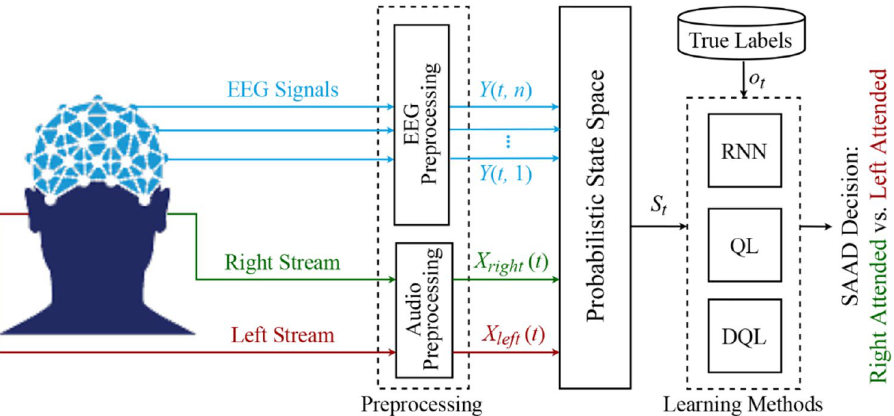
Figure 1. The block diagram of the proposed SAAD system using the dynamic learning methods of RNN, QL, and